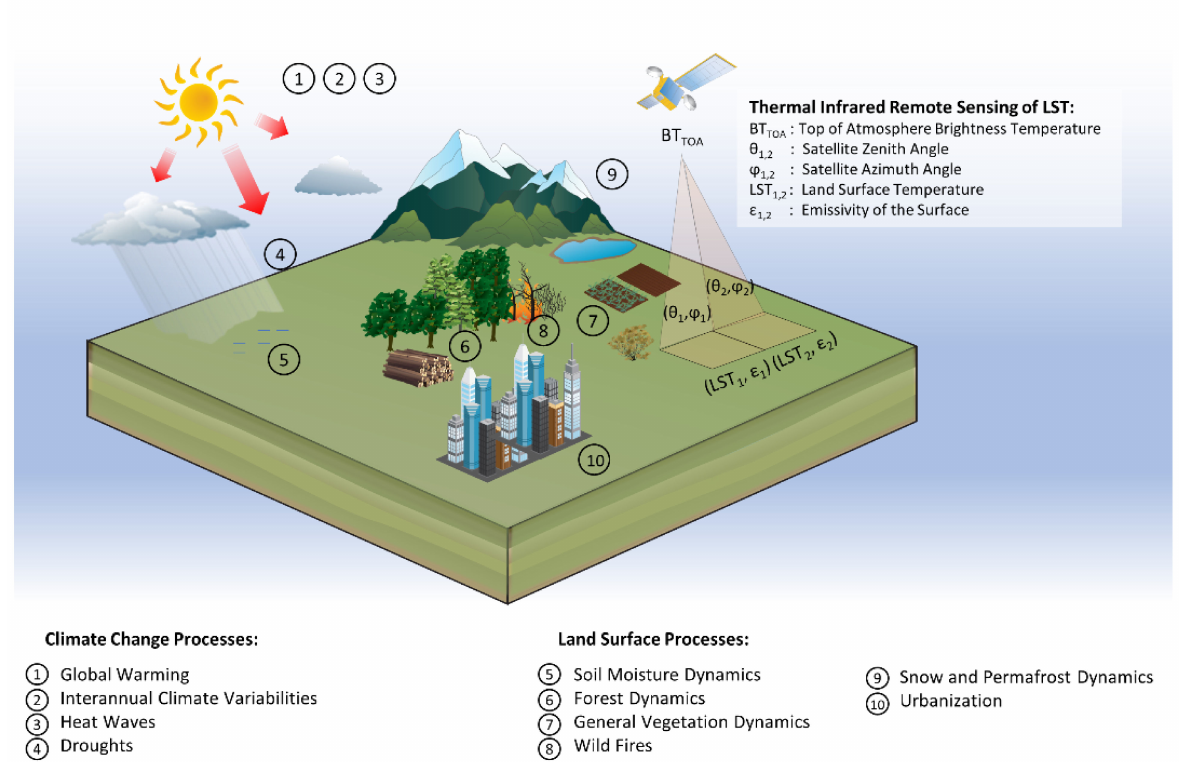
Figure 1. Overview figure illustrating climate change and land surfaces processes analyzed via LST dynamics as well as the principle of TIR remote sensing of LST, which is described in Section